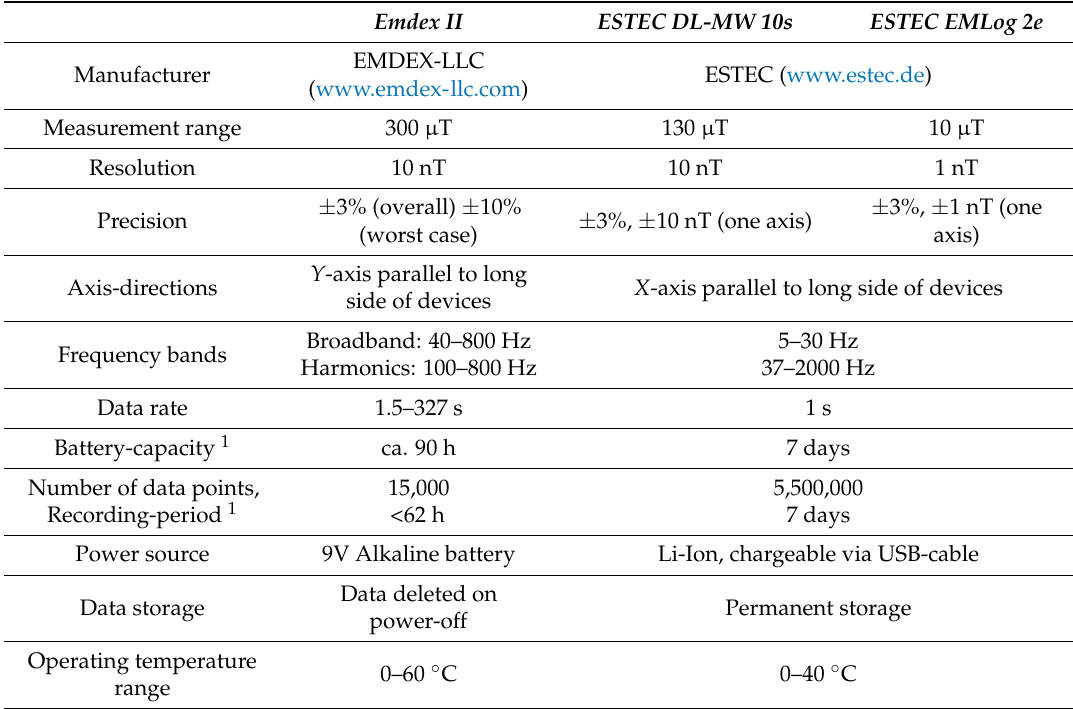
Table A1. Technical data of the magnetic field measurement